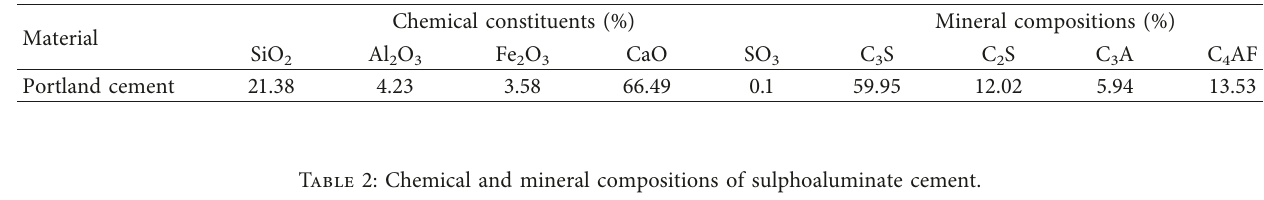
Table 1: Chemical and mineral compositions of portland cement.